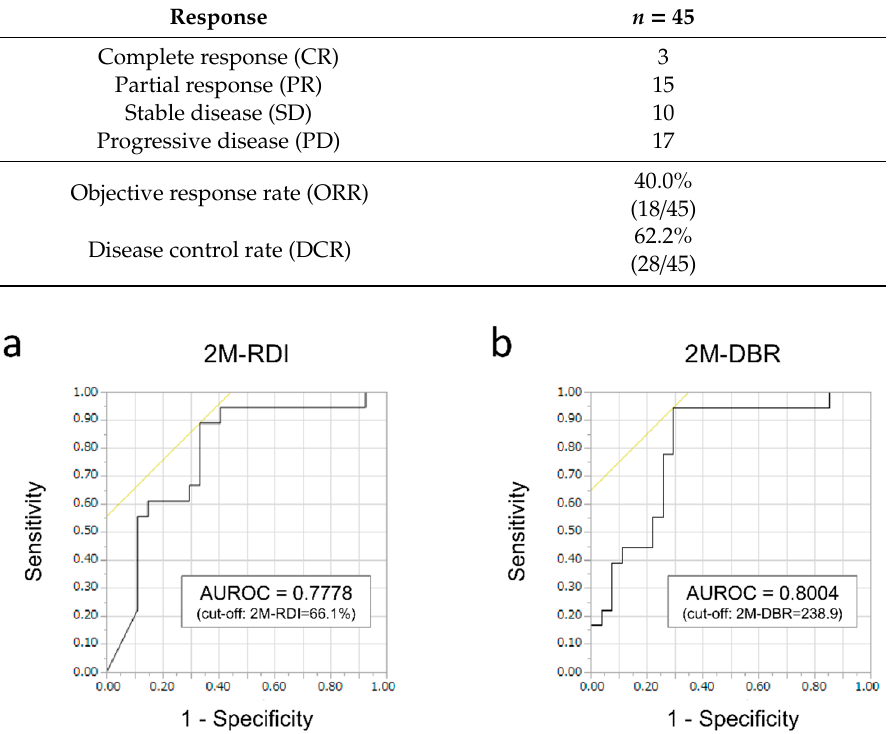
Table 2. Response to lenvatinib at 8–12 weeks after lenvatinib induction.